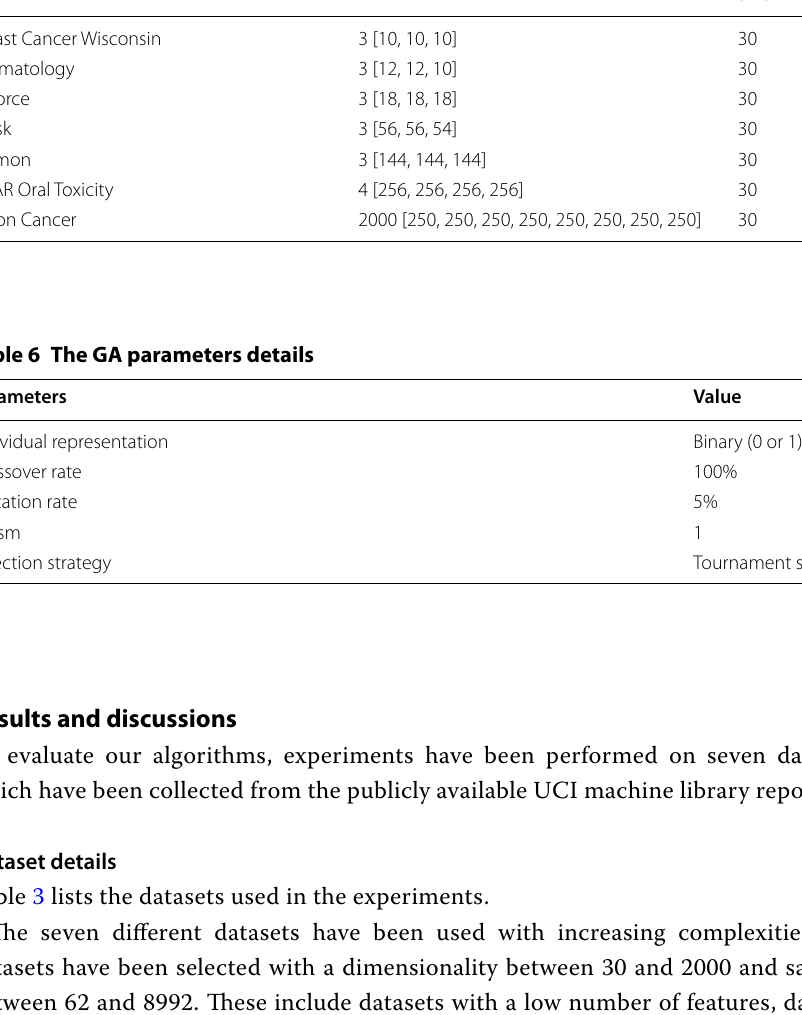
Table 5 The decomposition parameters used for the experiments Name